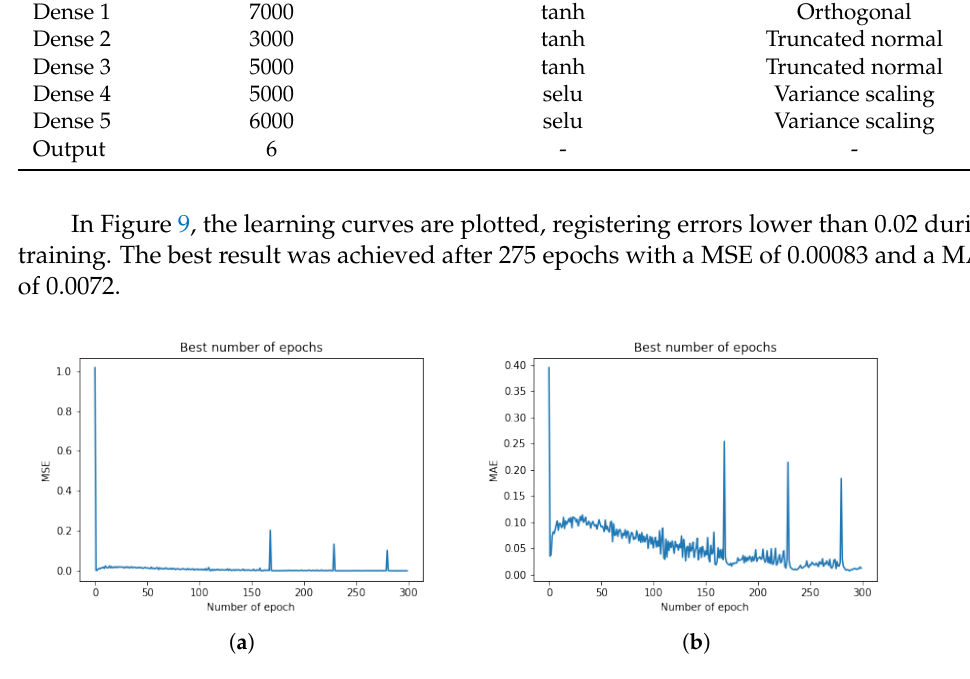
Figure 9. ( a ) MSE and ( b ) MAE evolution during the training process.